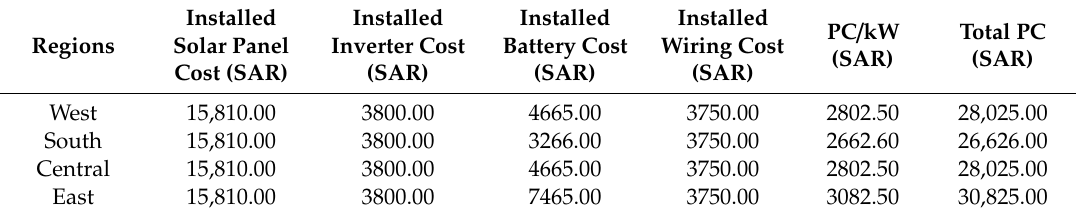
Table 11. The investment costs for new equipment in the KSA for di ff erent regions.